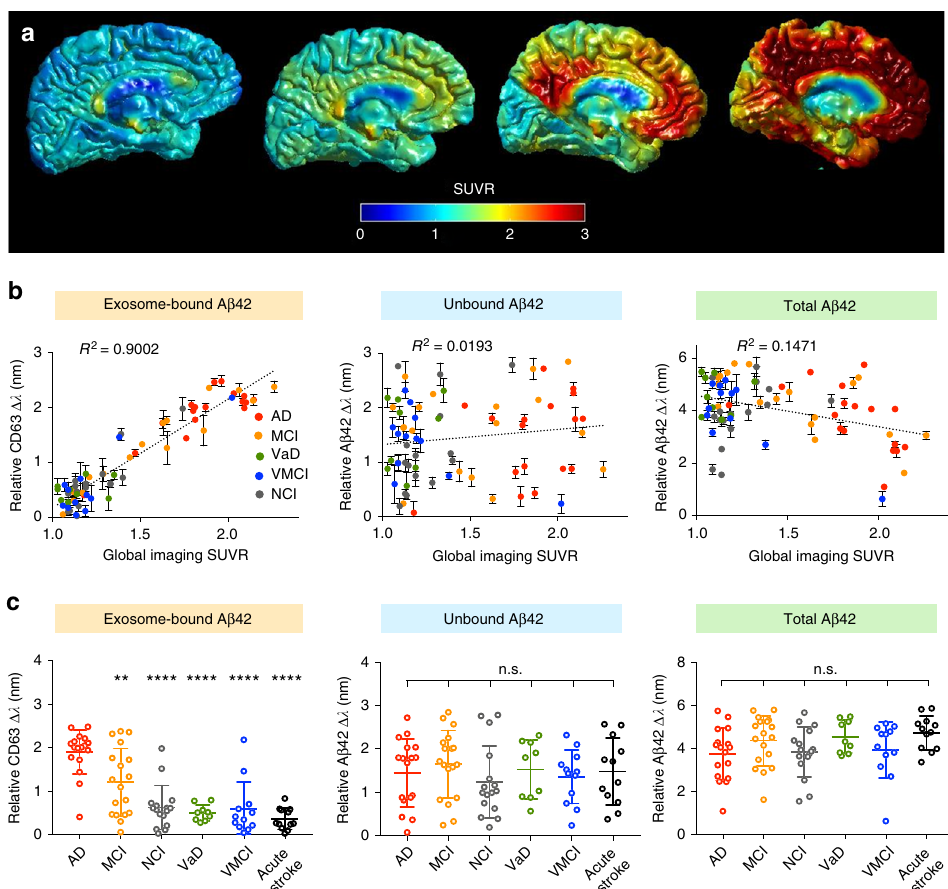
Fig. 4 Clinical correlation of circulating exosome-bound A β to brain imaging. a Representative reconstructed PET brain images from clinical subjects, showing increasing brain amyloid plaque load. SUVR, standardized uptake value ratio, of speci fi c brain region was normalized relative to the mean cerebellar gray matter intensity to determine brain amyloid plaque load. b Correlations of different populations of circulating A β 42 with global average PET brain imaging ( n = 72). Using the APEX assays, we measured the respective signals from exosome-bound A β 42 (left), unbound A β 42 (center), as well as total A β 42 (right), in blood samples of patients with Alzheimer ’ s disease (AD), mild cognitive impairment (MCI) as well as control subjects with no cognitive impairment (NCI), vascular dementia (VaD), and vascular mild cognitive impairment (VMCI). When correlated to the global imaging data of brain amyloid plaque, the exosome-bound A β 42 measurements demonstrated the best correlation (left, R 2 = 0.9002), as compared to that of the unbound A β 42 population (center, R 2 = 0.0193) or the total A β 42 (right, R 2 = 0.1471). c Analysis of different populations of circulating A β 42 in distinguishing various clinical groups ( n = 84). Only APEX measurements of circulating exosome-bound A β 42 (left) could distinguish between the AD clinical groups (AD and MCI), as well as from other normal (NCI) and clinical controls (VaD, VMCI and acute stroke). Neither the unbound A β 42 measurements (center) nor the total A β 42 measurements (right) showed any statistical signi fi cance among the different clinical groups (** P < 0.01, **** P < 0.0001, n.s., not signi fi cant, Student ’ s t -test). All measurements were made relative to IgG isotype control antibodies, and performed in triplicate. The data are displayed as mean ± s.d. in ( b , c ). Source data are provided as a Source Data fi